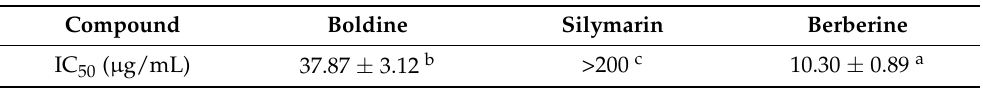
Table 1. Effect of different telomerase inhibitor compound treatments on IC 50 . Values are mean ± stan- dard error of 6 replicates. Mean with different letters differ significantly at p <